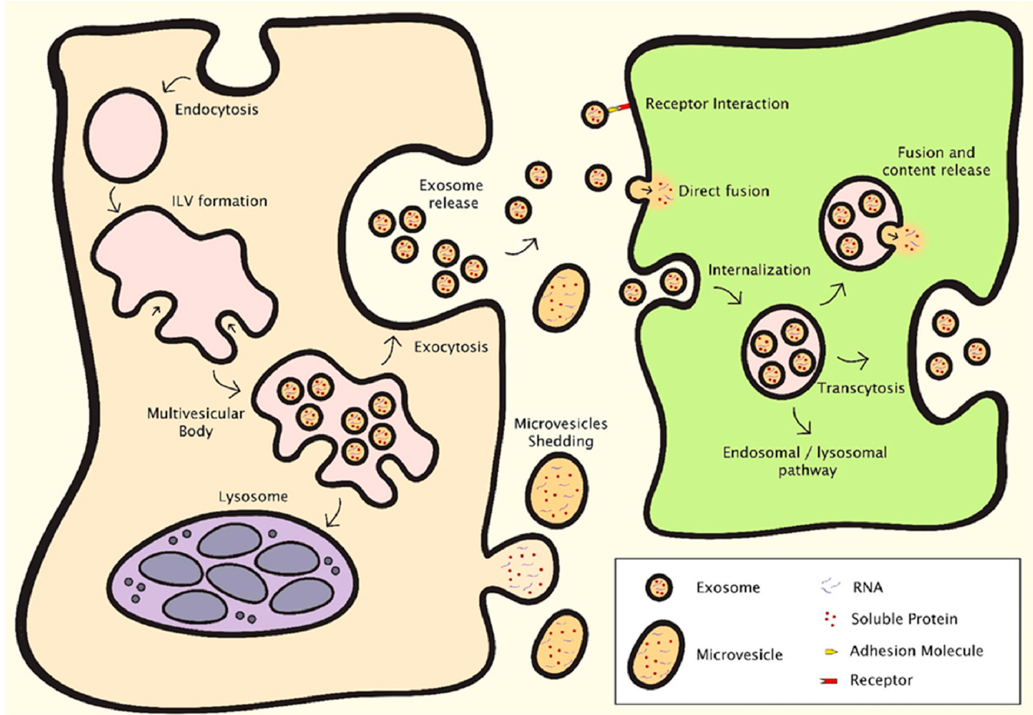
Figure 1. Mechanisms of EV formation and intercellular communication [38]. Exosomes and microvesicles are the EV types relevant in regenerative medicine, which contain nucleic acids, proteins and lipids. Exosomes are derived from the endosomal compartment through endosomal membrane invagination to form multivesicular bodies (MVB) containing intraluminal vesicles (ILV). The ILV are released as exosomes when the MVB fuse with the plasma membrane. Microvesicles shed directly from the plasma membrane. EVs facilitate intercellular communication through several processes. They can interact with surface receptors on the recipient cell, or release cargo into the recipient cell either through direct fusion with the cell membrane or by endocytosis.